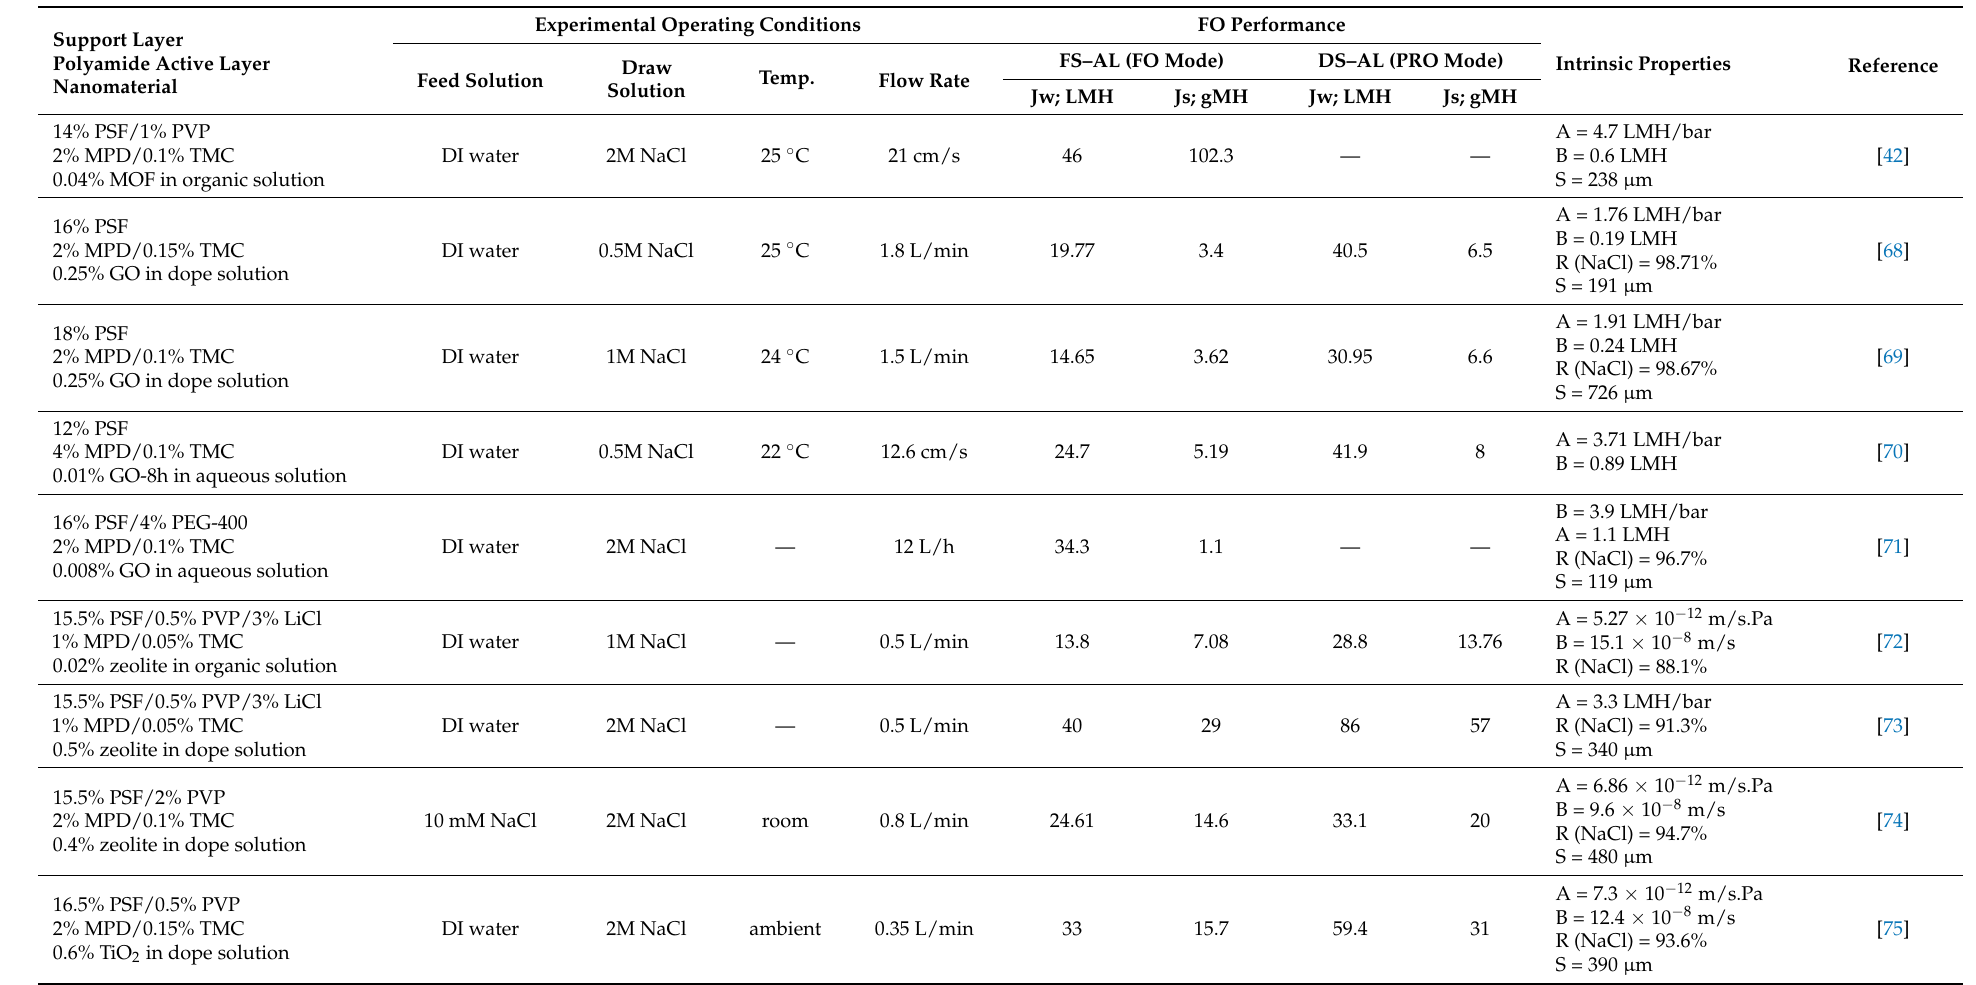
Table 1. Summary of the studies on FO performance of nanoparticle-modified TFC